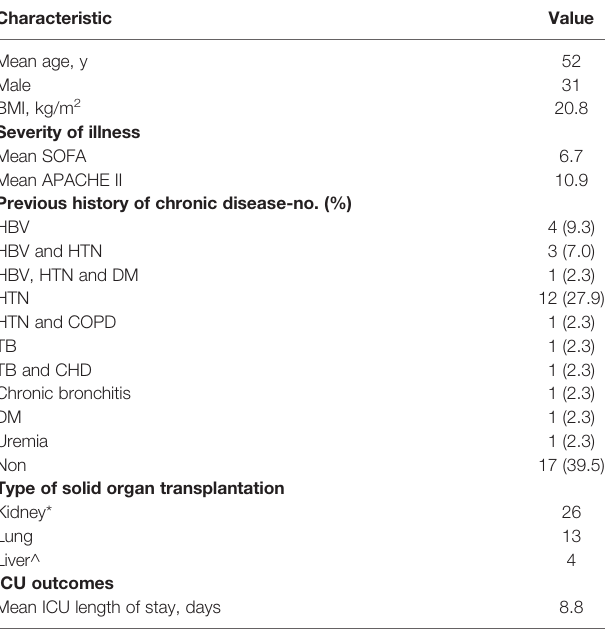
TABLE 1 | Demographic and Clinical Characteristics of the 43 Recipients with solid organ